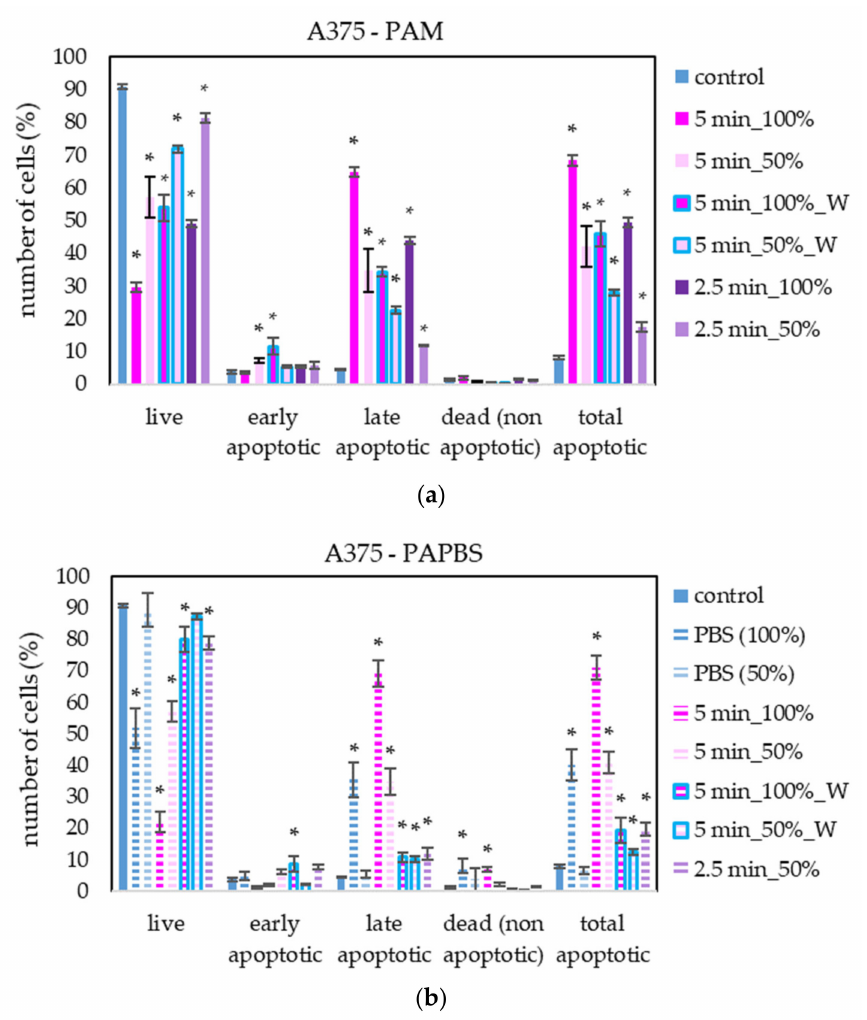
Figure 7. The effect of PAL on apoptosis induction in human melanoma cells A375, measured 24 h after PAL application. Plasma-activated medium—PAM ( a ) or plasma-activated PBS—PAPBS ( b ) activated for 2.5 or 5 min in 100% or 50% concentration were used. Time of PAL action was 24 h (without blue frames) or 30 min, after which PAL were replaced with untreated medium (“washing”, W, blue frames). The significant results ( p < 0.05) are marked with *. Significance of 100% PAPBS, resp. 50% PAPBS was tested compared to in 100% PBS, resp. 50% PBS, significance of other